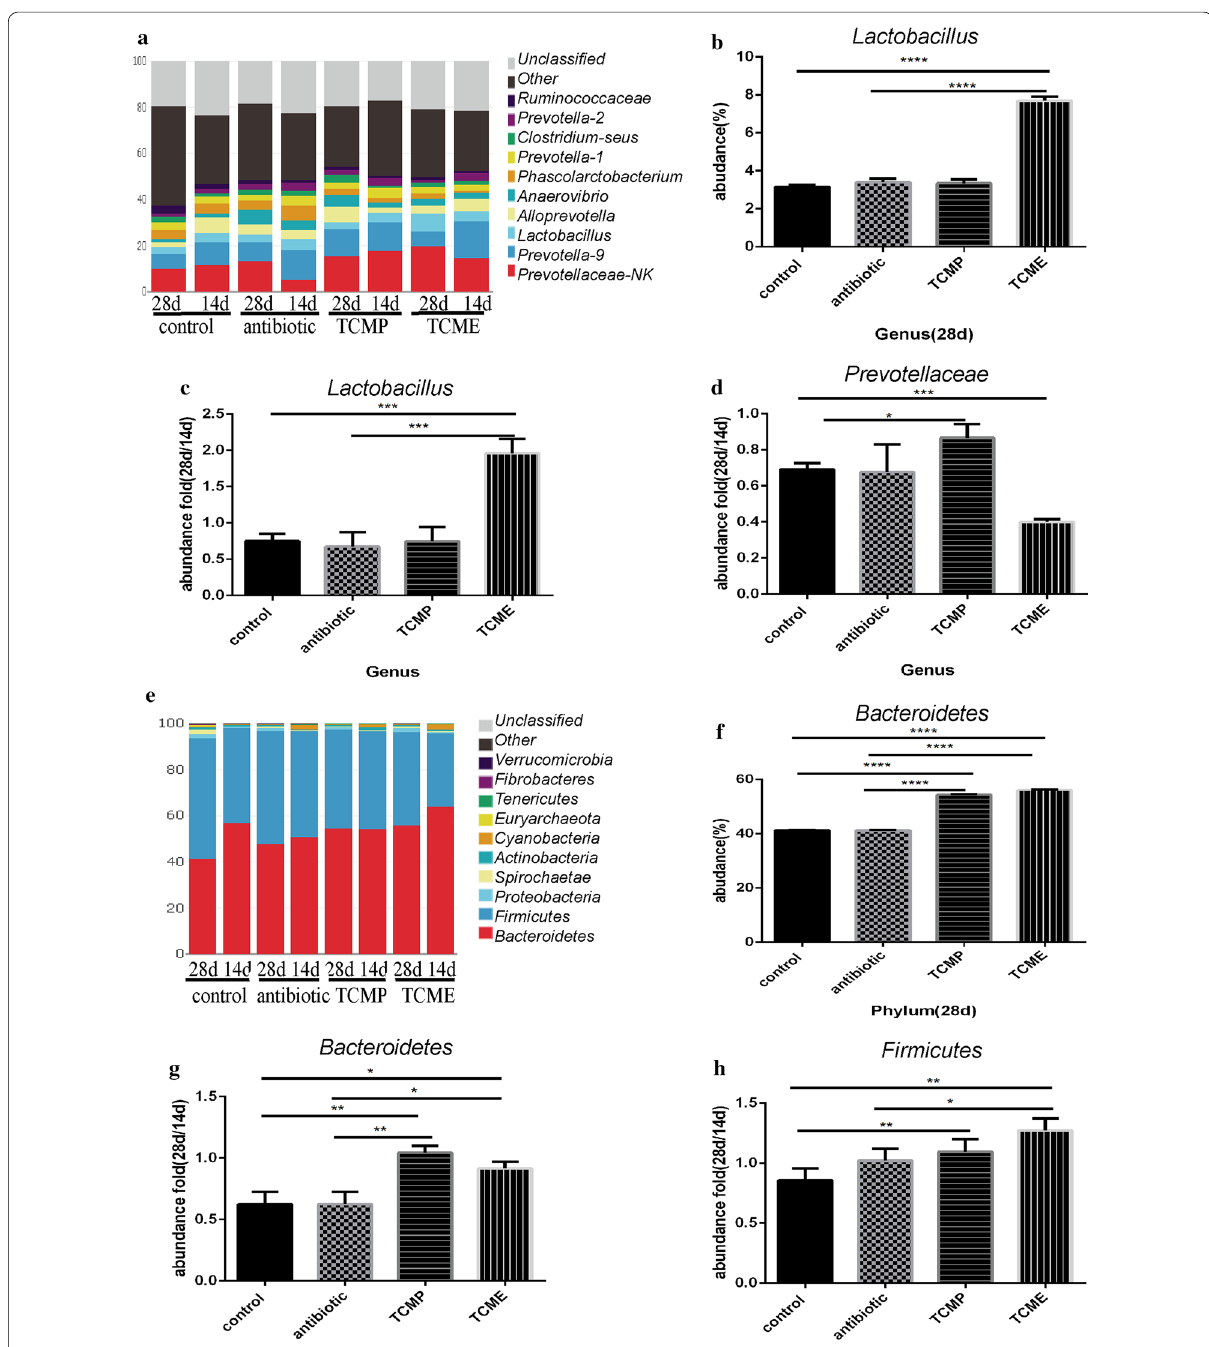
Fig. 8 Effect of coix seed on the composition of colonic microbiota with respect to genus and phylum. a Effect of coix seed on the composition of colonic microbiota with respect to genus in weaned pigs. b Abundance of genus Lactobacillus. c Fold abundance of genus Lactobacillus (28D/14D). d Fold abundance of genus Prevotellaceae (28D/14D). e Effect of coix seed on the composition of colonic microbiota with respect to phylum in weaned pigs. f Fold abundance of phylum Bacteroidetes (28D/14D). g Abundance of phylum Lactobacillus . h Fold abundance of phylum Firmicutes (14D). (* p < 0.05; ** p < 0.02; *** p < 0.01, **** p <